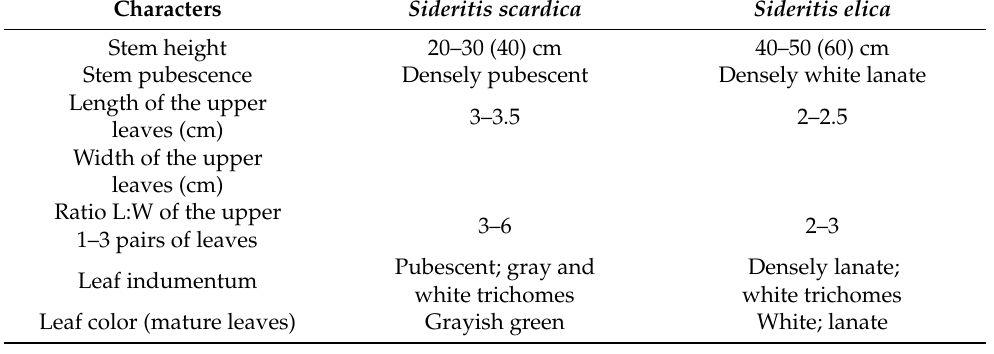
Figure 3. Boxplot for the most discriminant morphological characters. L1, W1, R1: length, width, and ratio of length/width of the uppermost leaf pair; L2, W2, R2: the same traits for the second leaf pair.